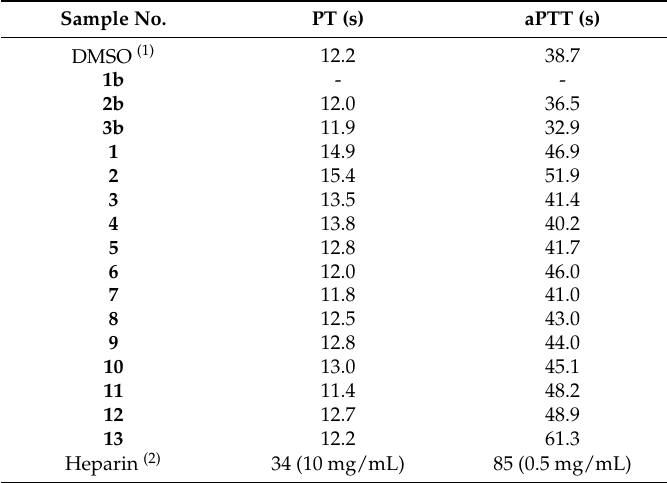
Table 1. Anticoagulant activities of 1b – 3b , and 1 – 13 at 30 µ g/mL.